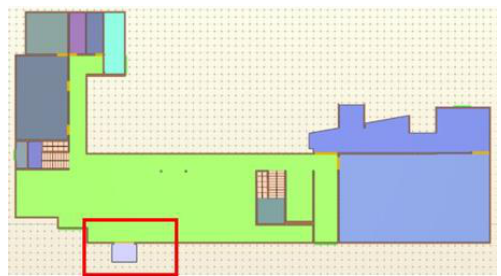
Figure 2. Ladders A and B configuration diagram in Scenario A.